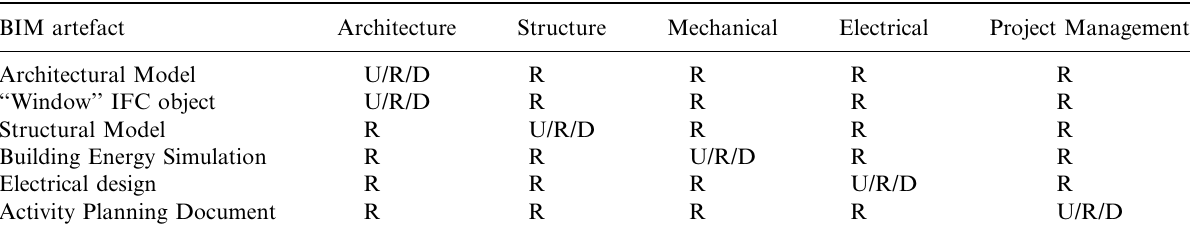
Table 4. Project access rights